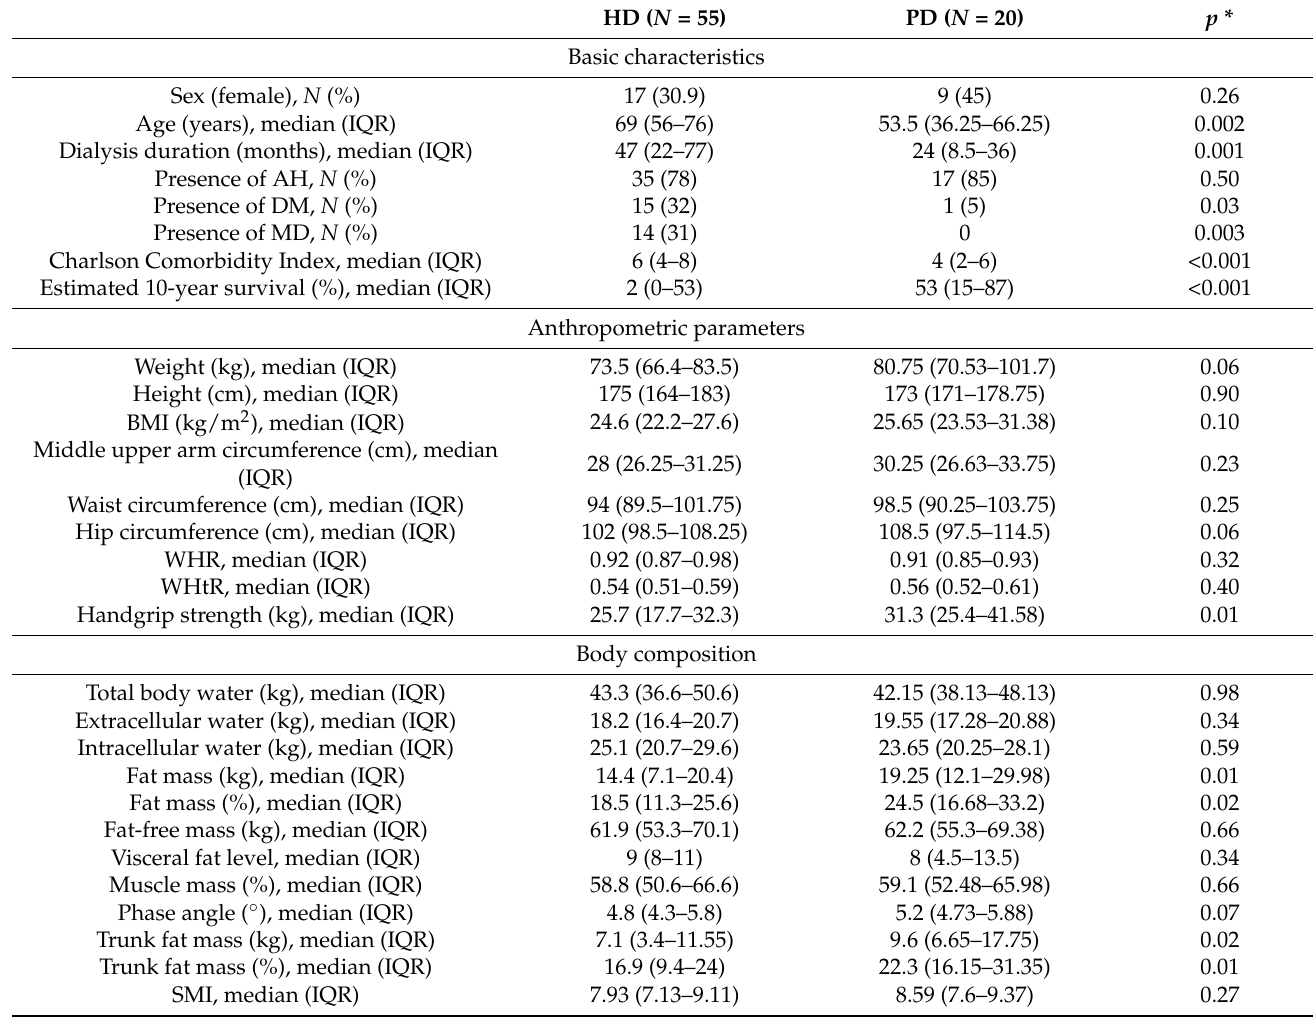
Table 1. Basic characteristics and differences regarding dialysis